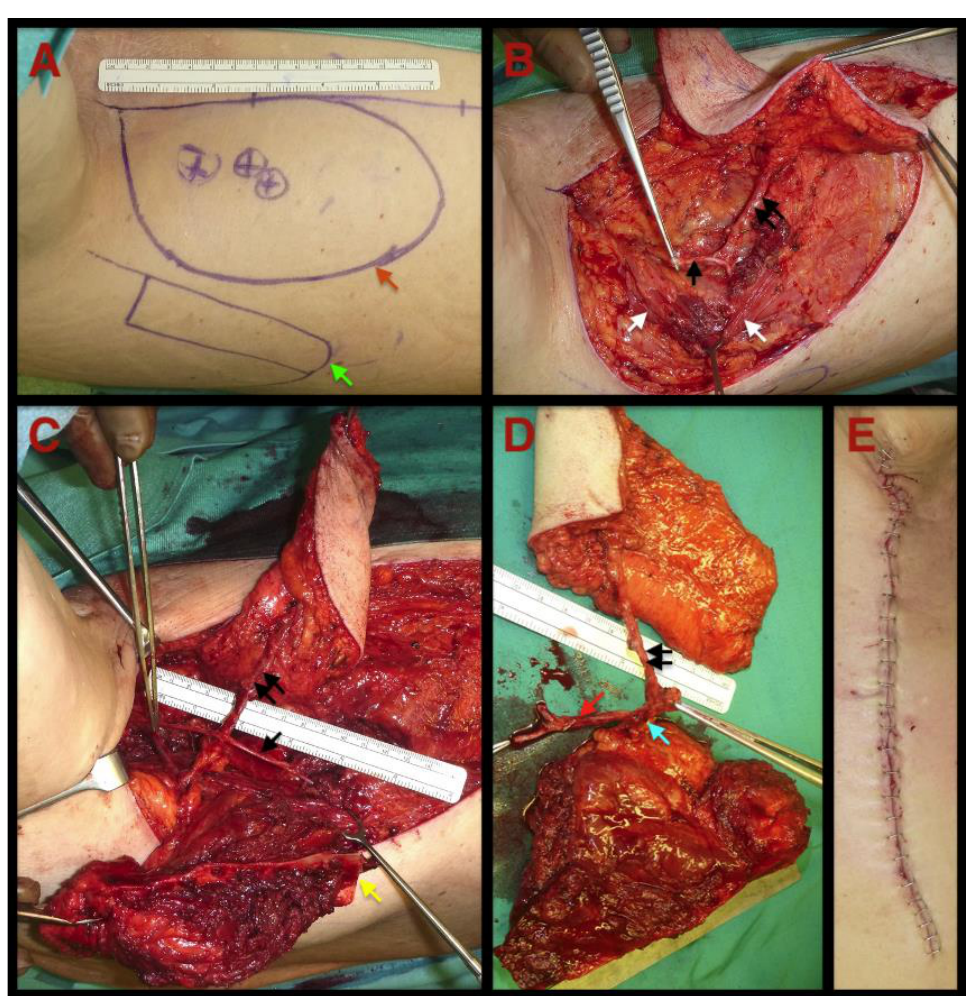
Figure 1. Intraoperative pictures of a 74-year-old male patient while TDAP-Scap-aa flap harvesting: ( A ) flap design: In a lateral decubitus position (arm fixed in 90° abduction) the skin paddle (single orange arrow) and the lateral scapular boarder (single green arrow) are marked. Further, the perforators supplying the skin are marked on the skin paddle after identification with a Doppler ultrasound; ( B ) skin paddle: A pliable muscle-free soft tissue component based on a perforator of the thoracodorsal artery (black double arrow) is dissected after preserving the thoracodorsal nerve (black single arrow ) and the latissimus muscle (white single arrow). The skin paddle’s thickness is about 1 cm; ( C ) bone: The lateral scapula boarder is osteomised (hard tissue component — yellow arrow). A muscle cuff is left on the scapula. The harvested bone is supplied by the angular artery. The single black arrow indicates the preserved thoracodorsal nerve. The double black arrow marks the perforator to the skin; ( D ) raised free flap: Soft and hard tissue components are harvested separately. The harvested microvascular bone and the skin paddle can be moved independently from each other. The lateral scapula bone supplied by the angular artery (single blue arrow) and the perforator-based (double black arrow) skin component are both based on the thoracodorsal artery (single red arrow); ( E ) direct wound closure: On the donor site, a primary wound closure can be achieved although large amounts of soft and hard tissues were harvested. Note: Pictures are taken from case number 19. Exclusion criteria were previous operation in the head and neck region, consecutive operation after the primarily curative operation (HNSCC), occurrence of a concomitant disease with hospitalisation after the operation, missing informed consent, lost to follow- up, primary tumour size stages smaller than pT2 (HNSCC) and defect sizes not needing microvascular free flap reconstruction (ORN).